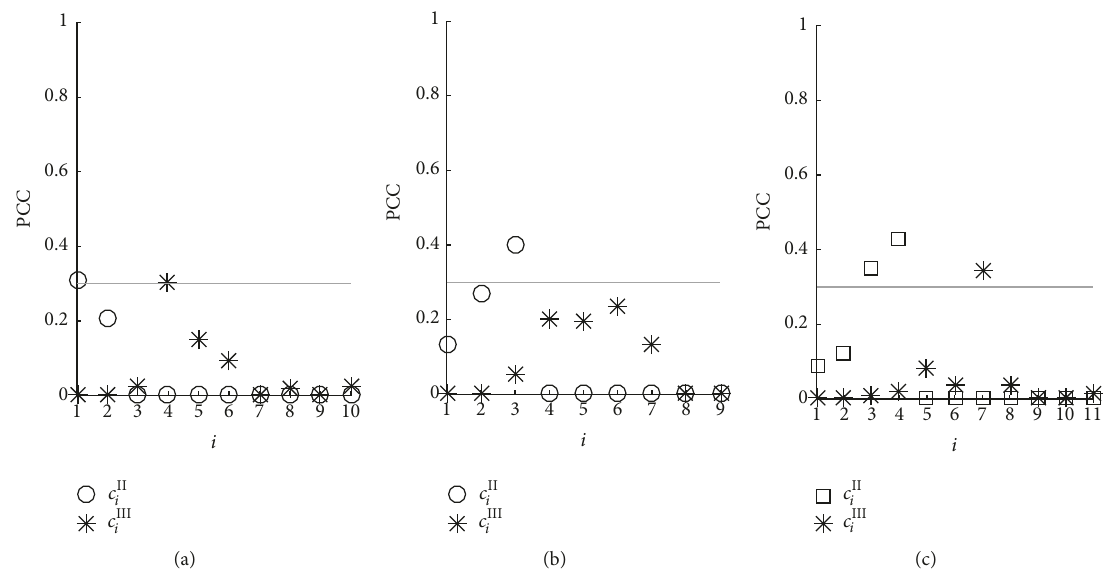
Figure 15: PCC values of Case 1 estimated taking into account (a) EMD, (b) EEMD, and (c) CEEMDAN.